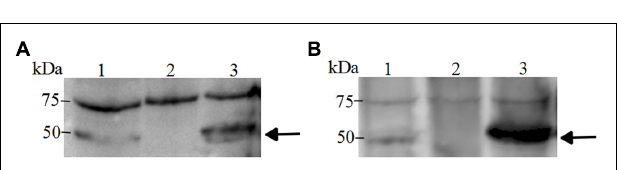
FIGURE 2 | Western blotting of TolC1 and TolC2 (A), Western blotting of TolC1 in whole-cell lysate of A. pleuropneumoniae probed with